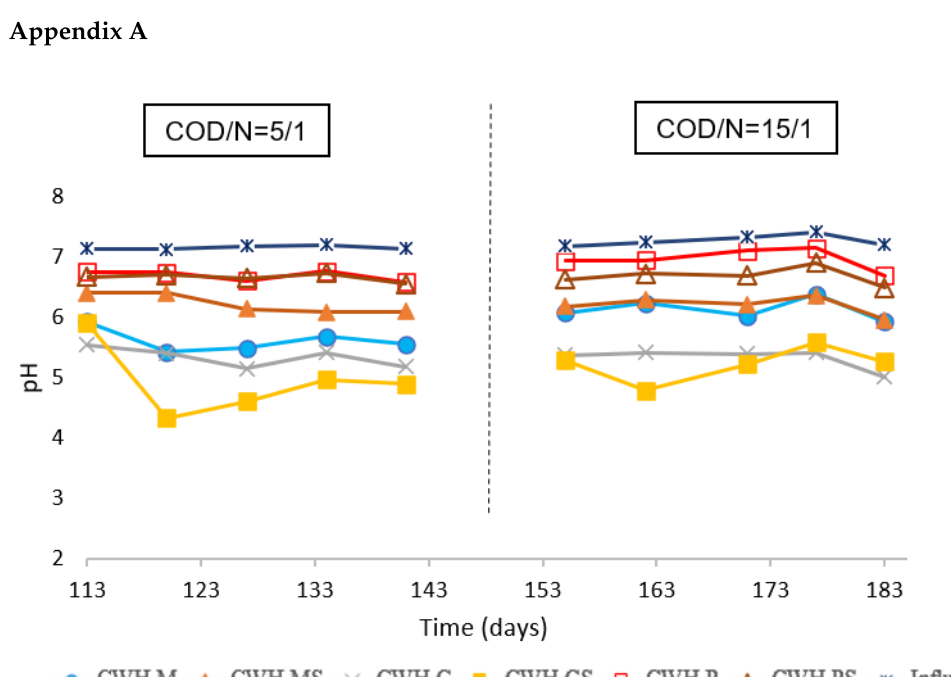
Figure A1. Influent and effluent pH of all the studied CWH. CWH-MS and CWH-M indicate mineral wool + syngonium and mineral wool unplanted groups respectively. CWH-CS and CWH-C indicate cocopeat + syngonium and cocopeat unplanted groups respectively. CWH-PS and CWH-P indicate pumice + syngonium and pumice unplanted groups respectively.